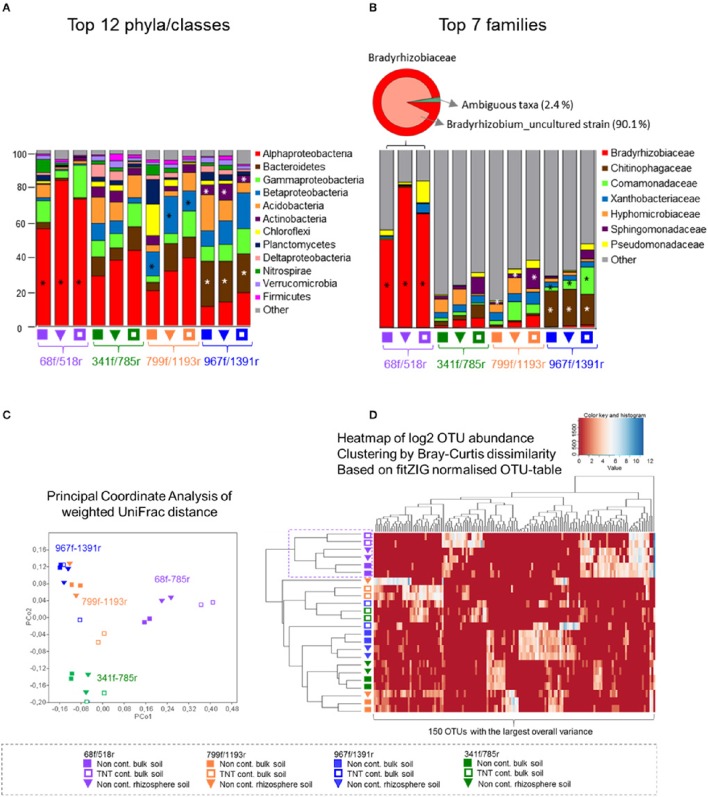
Abundance distribution of the most dominant phyla, Proteobacteria classes, and families, principal coordinate analyses, and heatmap of the top 150 OTUs. The relative abundance bar charts show the 12 most dominant phyla and Proteobacteria classes (A) and seven most dominant families (B) per primer pair and soil type, based on pyrosequencing data of bulk soil and Acer pseudoplatanus rhizosphere soil samples, Zwijndrecht, Belgium. Significant different lineages between the primers are indicated with a star (Kruskal–Wallis p < 0.05). (C) PcoA was calculated based on the CSS-normalized data and weigthed UniFrac distance matrix in QIIME. (D) The heatmap was generated based on the fitZIG normalized OTU-table (Paulson et al., 2013) and shows the 150 OTUs with largest overall variance clustered by Bray-Curtis dissimilarity.